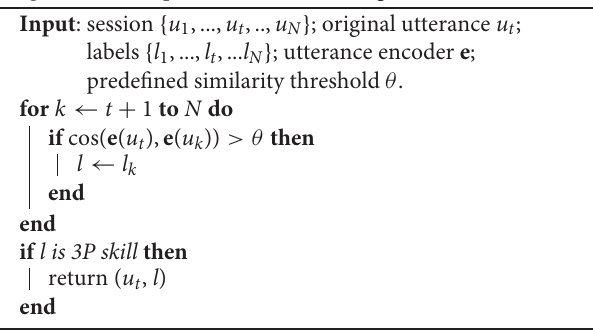
Algorithm 1: Rephrase-based